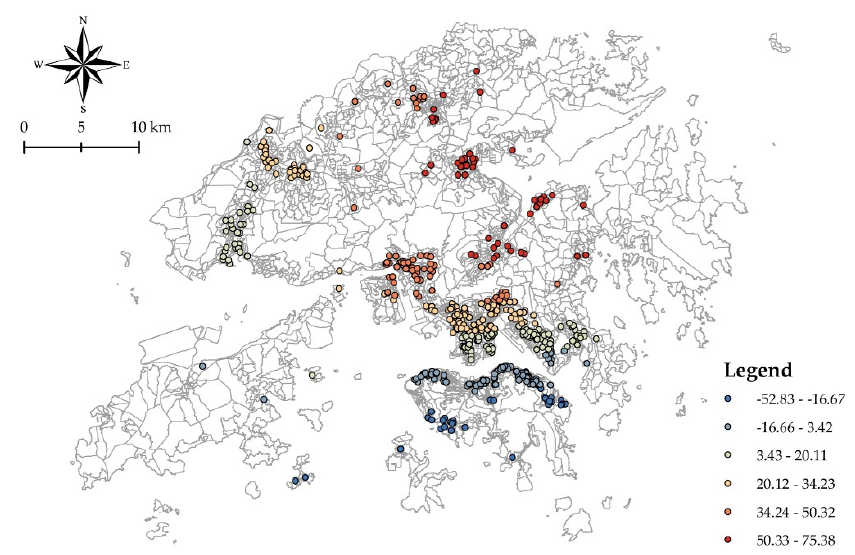
Figure 3. Geographical distribution of the coefficient of street greenery (400 m).